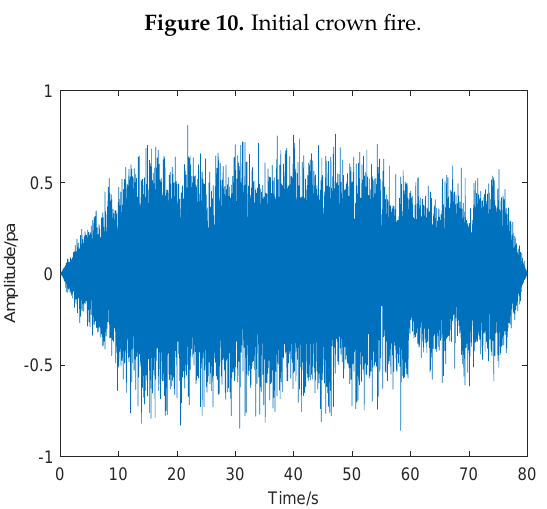
Figure 11. Time-domain sound